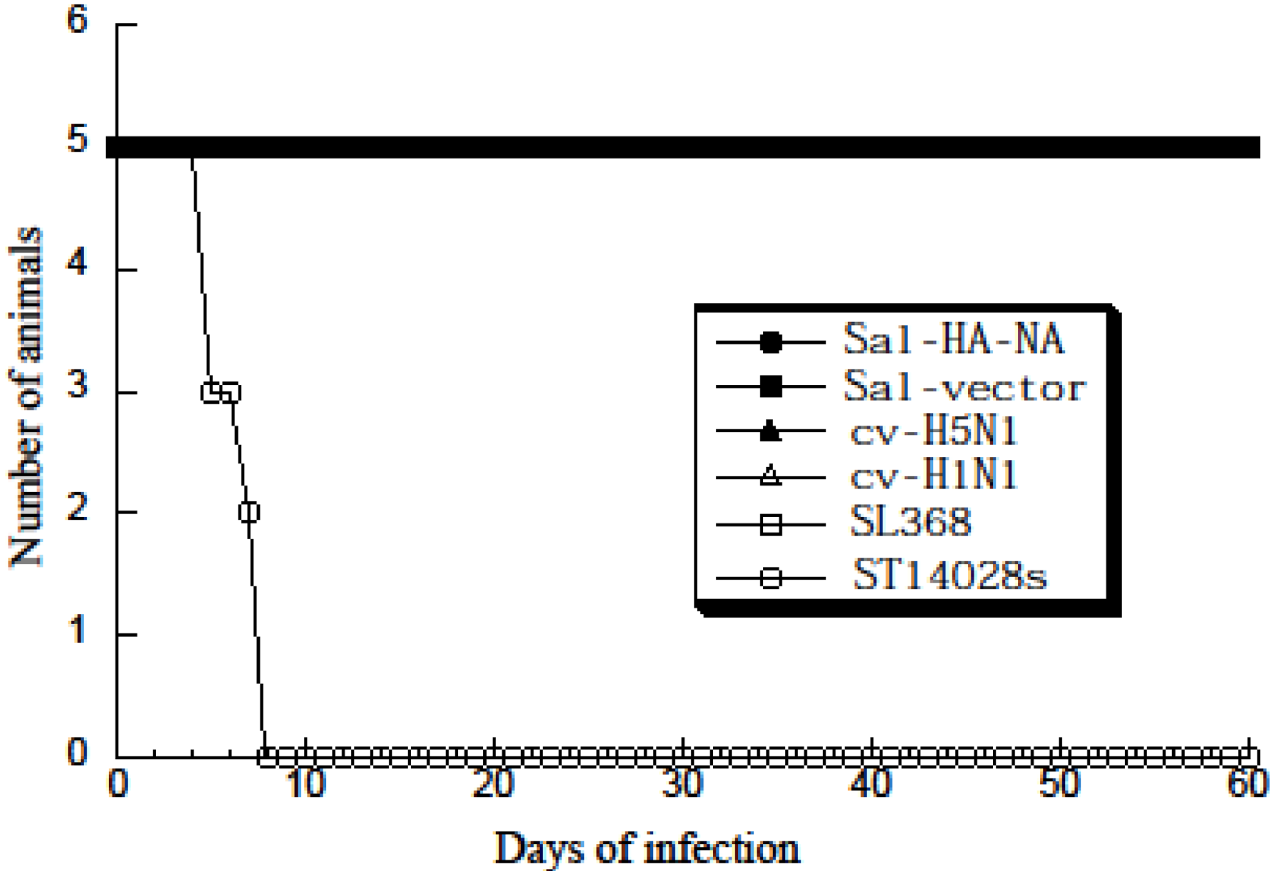
Fig 3. Toxicity and virulence of different Salmonella strains in BALB/c mice. Mice (5 animals per group) were either inoculated intramuscularly with the commercial H5N1 (cv-H5N1) and H1N1 vaccines (cv-H1N1) or intragastrically with PBS, the wild-type strain ST14028 (1 × 10 3 CFU), and vaccine strain SL368 (1 × 10 9 CFU) carrying the empty vector construct pVAX1 (Sal-vector) and constructs p5HA and p5NA (Sal-HA-NA). The mortality of the animals was monitored for 60 days. Humane (non-lethal) endpoints were used during the experiments and mice were euthanized with overdose inhalational CO 2 to limit suffering, when they exhibited weight loss of more than 30%, lethargy, ruffled hair coat, or hunched posture. (Fig 4) [42]. At day 42, mice immunized with vaccine Sal-HA-NA, in which SL368 carried con-